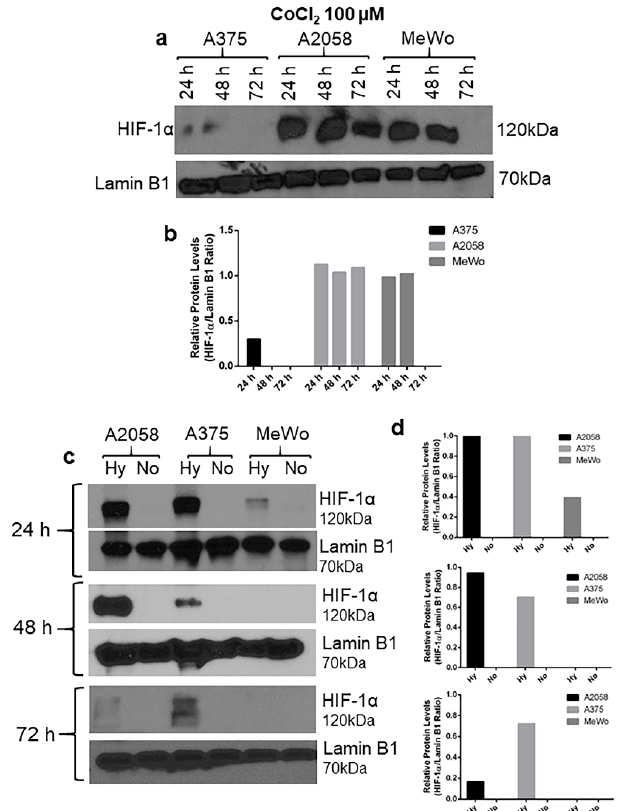
Figure 2. Induction of HIF-1 α expression by cobalt chloride (CoCl 2 ) or hypoxic conditions: ( a ) A2058, A375, and MeWo cells were treated with CoCl 2 at a concentration of 100 µ M. Nuclear protein lysates were collected at 24, 48, and 72 h post-treatment. ( b ) Densitometric quantification of HIF-1 α immunoblots relative to nuclear Lamin B1 protein expression. ( c ) A2058, A375, and MeWo cells were incubated on hypoxic (Hy) or normoxic (No) conditions. Nuclear protein lysates were collected at 24, 48, and 72 h post-treatment. Expression of HIF-1 α was detected by Western blot; Lamin B1 was used as a loading control. ( d ) Densitometric quantification of HIF-1 α immunoblots relative to nuclear Lamin B1 protein expression. A representative experiment is shown from three